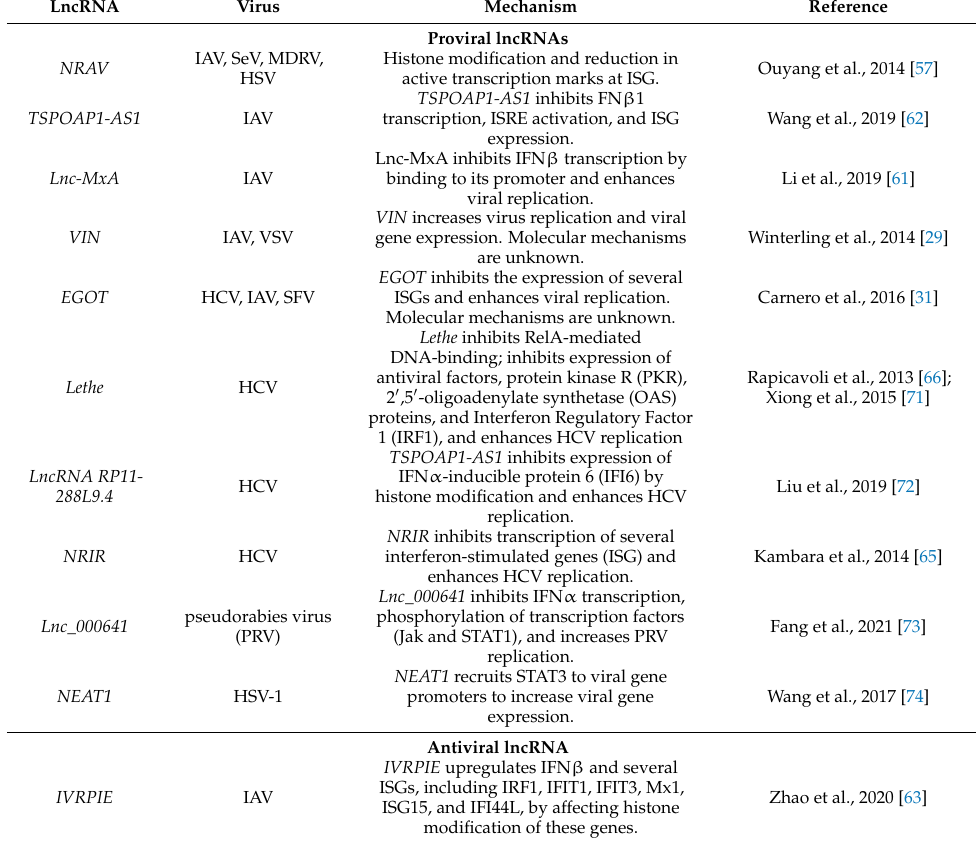
Table 1. Cellular and viral nuclear lncRNAs regulate viral replication and